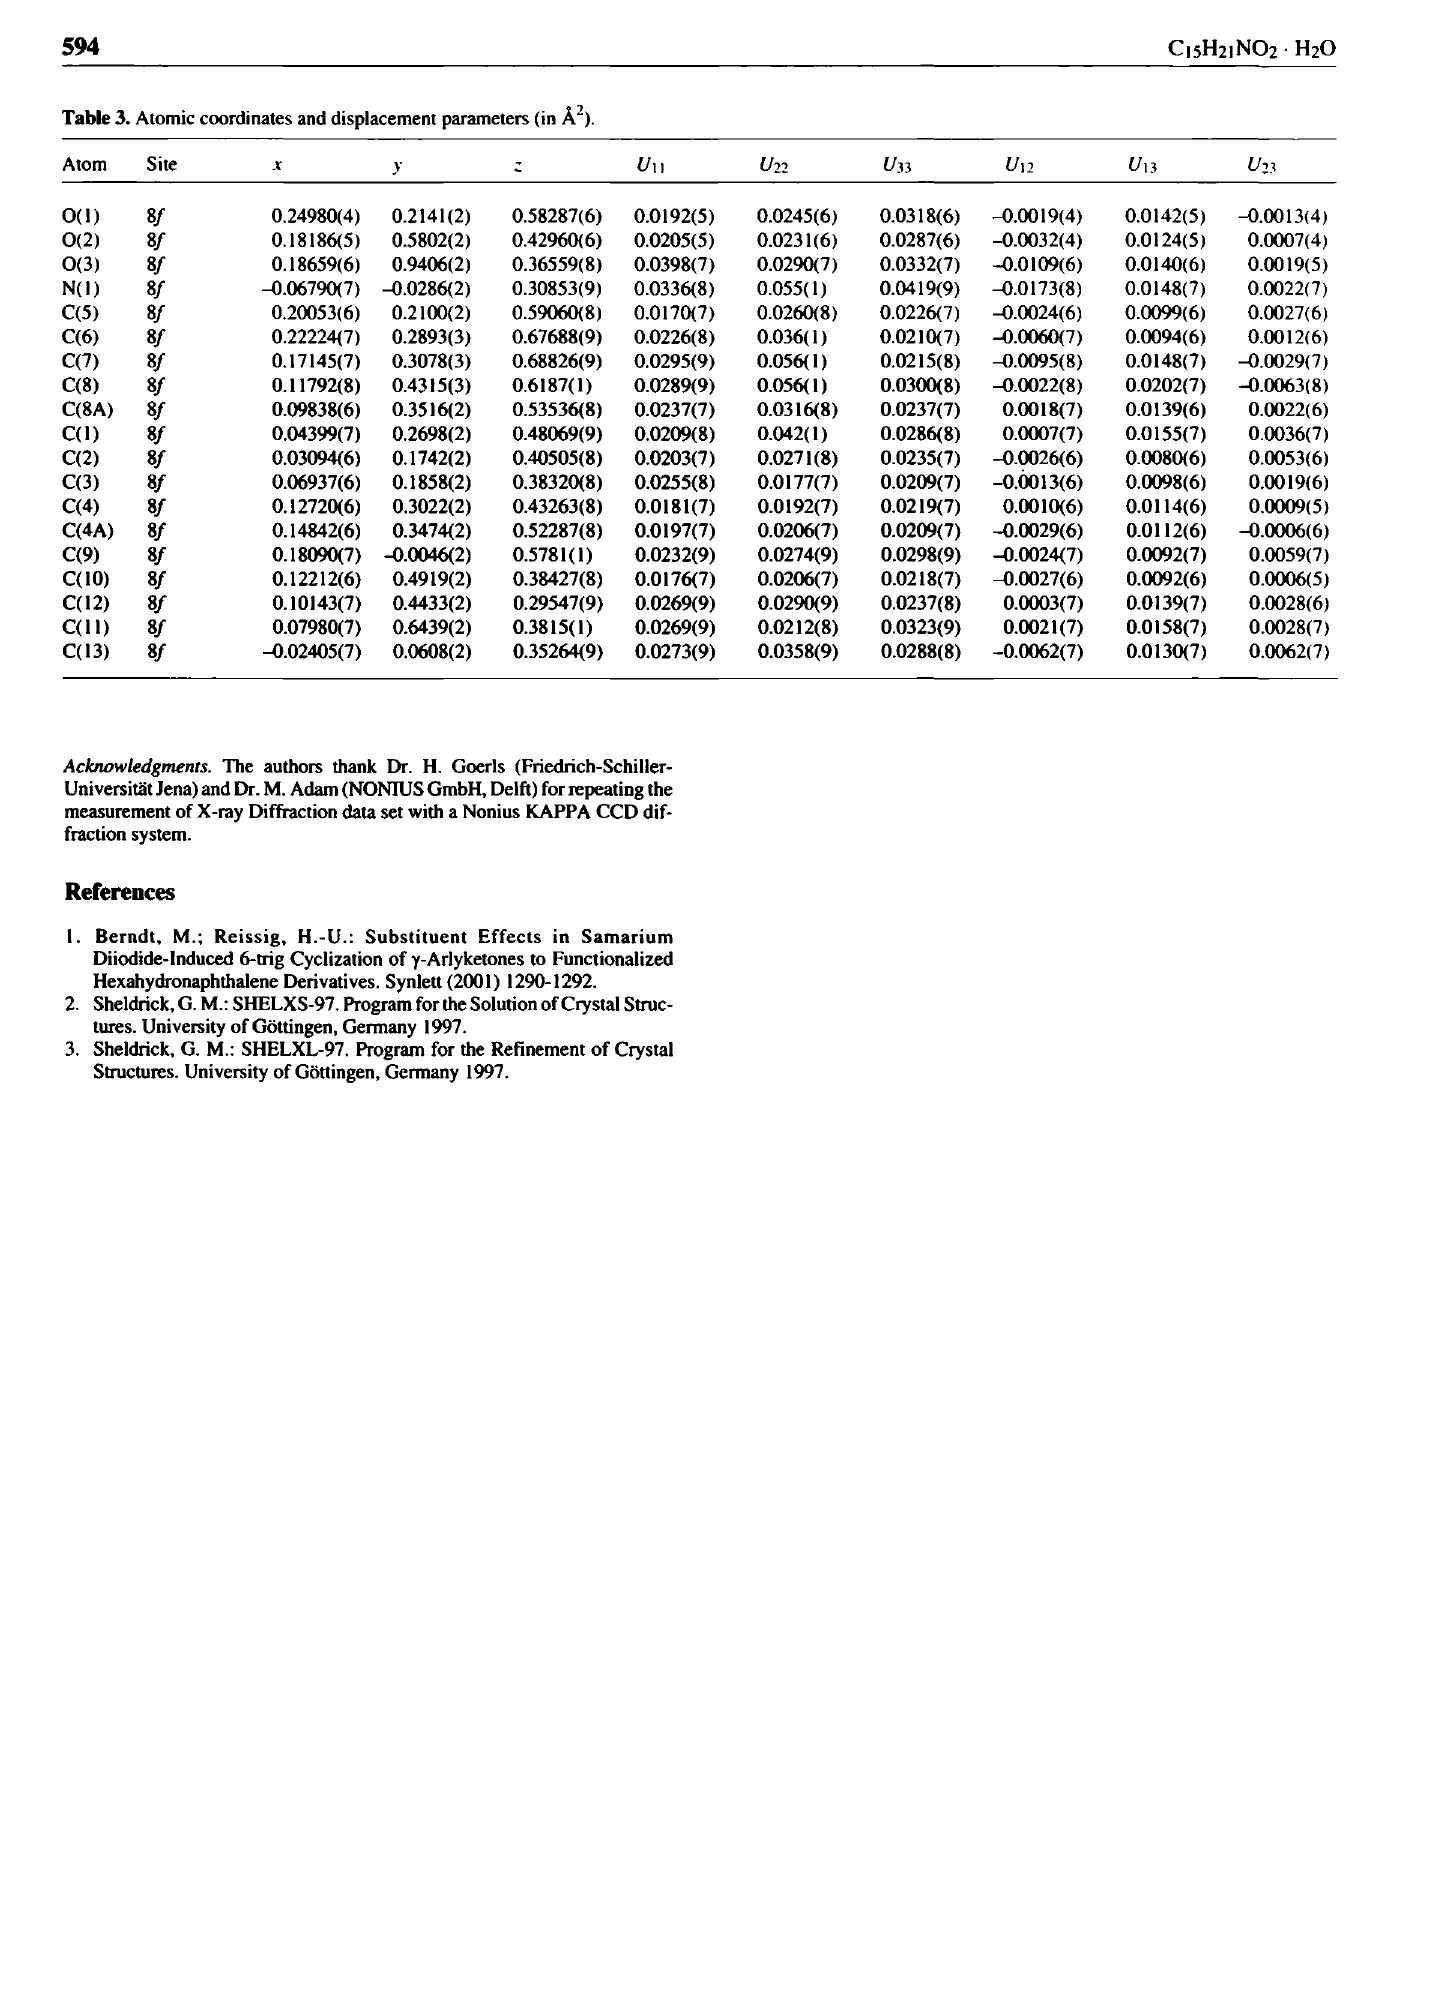
Table 3. Atomic coordinates and displacement parameters (in Ä 2